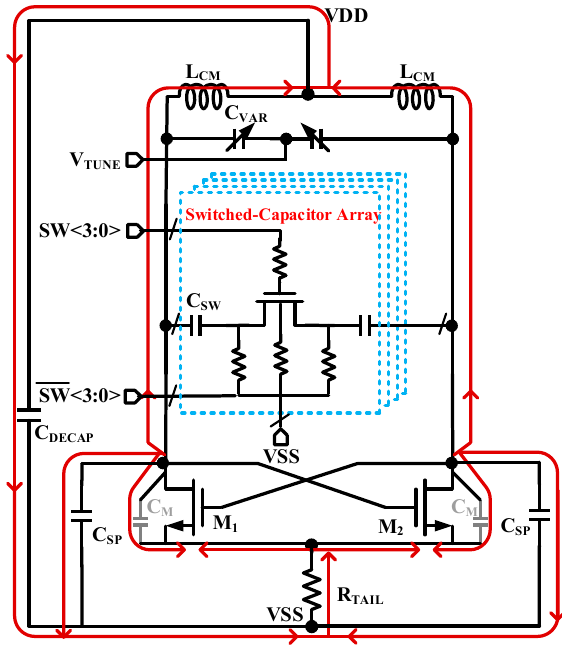
Figure 4. The common-mode loop of the VCO.